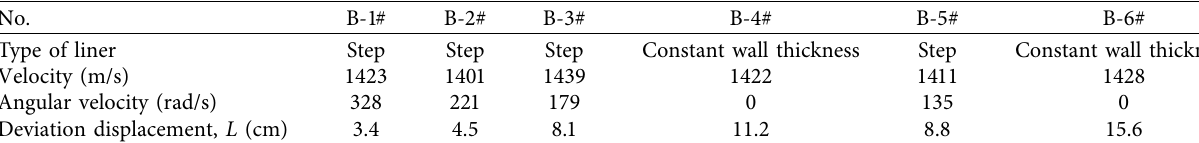
Table 3: Test results.